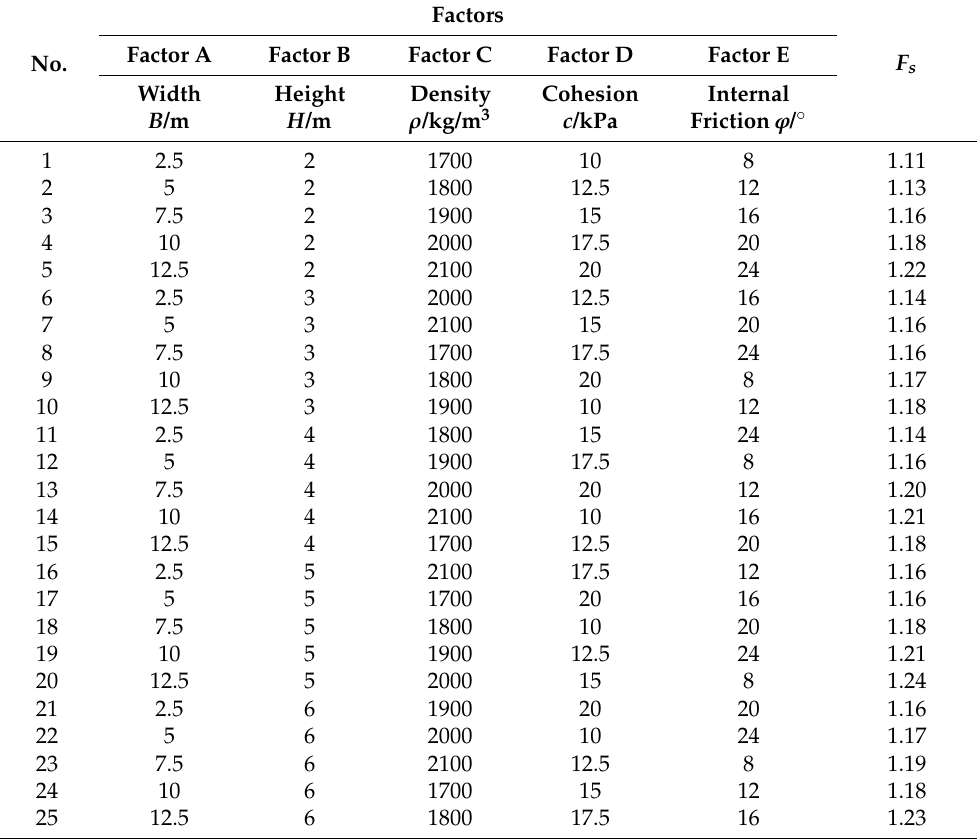
Table 5. Orthogonal test scheme and stability